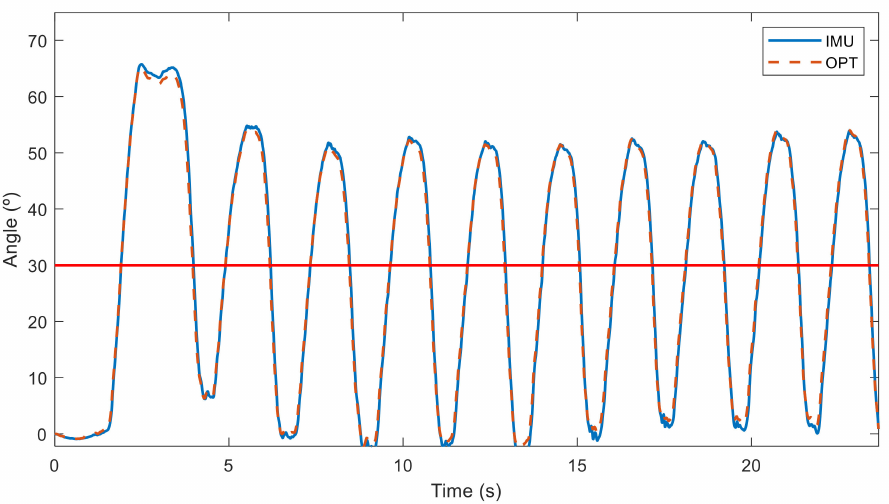
Figure 13. Angles measured by sensors in the sagittal plane from a man with experience C performing deadlifts with a neutral spine position (maximum accepted spine deviation in solid